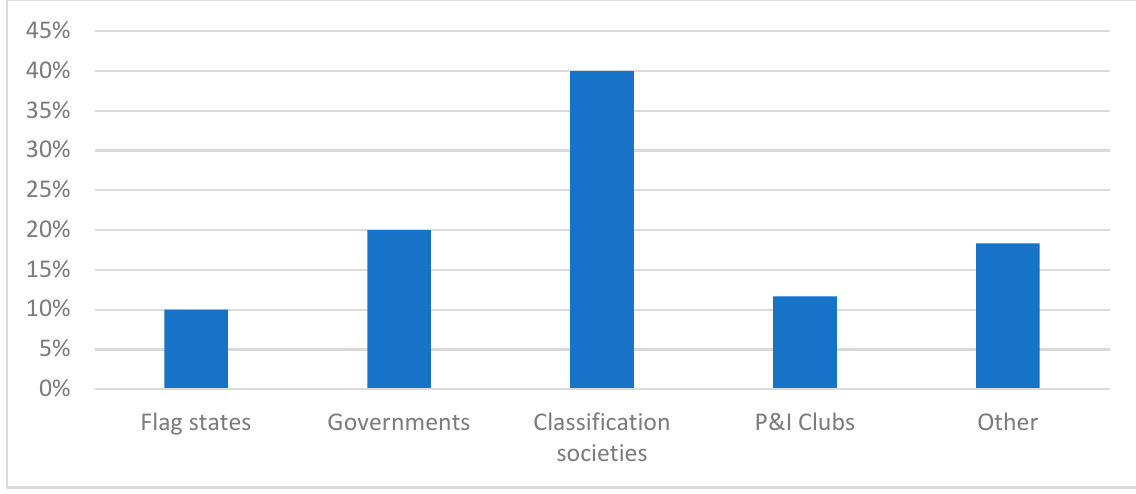
Figure 4. Which agency is more suitable to assist and guide the maritime transport sector in addressing cyber security? (Asia and Europe).